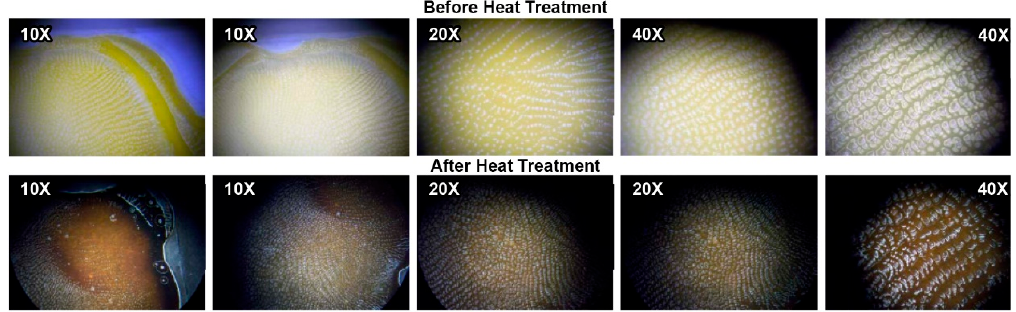
Figure 11. Optical micrographs of thin-films of ionic polymer P-1 before and after heat treatment at 550 °C in air for 30 min at different magnifications.